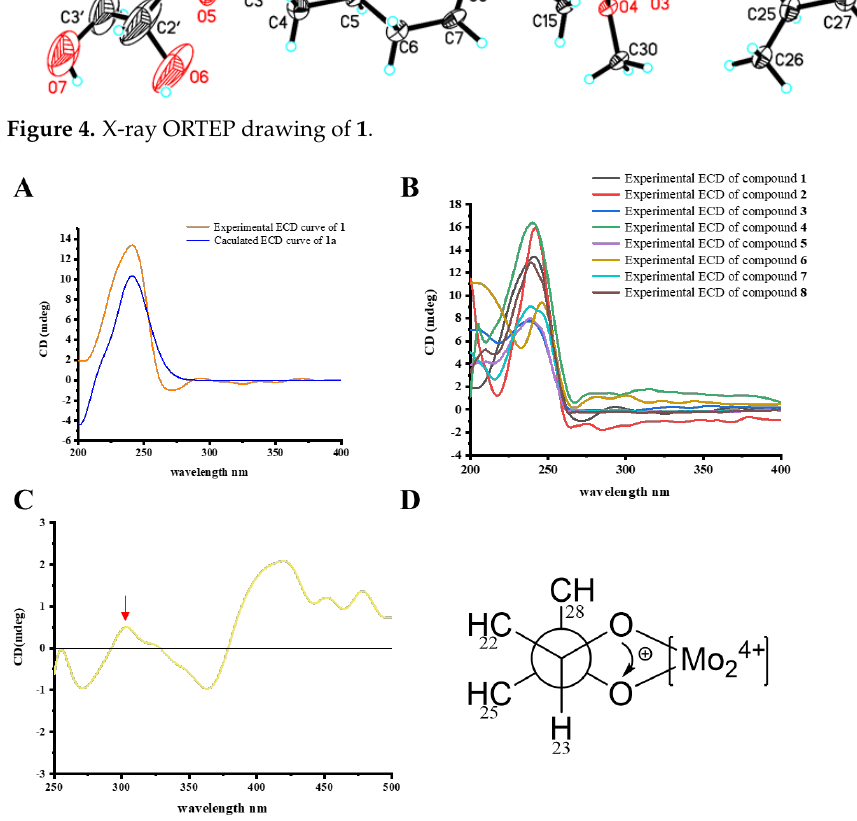
Figure 5. ( A ) Experimental and calculated ECD spectra of 1 . ( B ) Experimental ECD spectra of 1 – 8 . ( C ) ICD spectrum of the Mo 2 4+ complex of 7 in DMSO. ( D ) Conformations of the Mo 2 4+ complex of 3 .